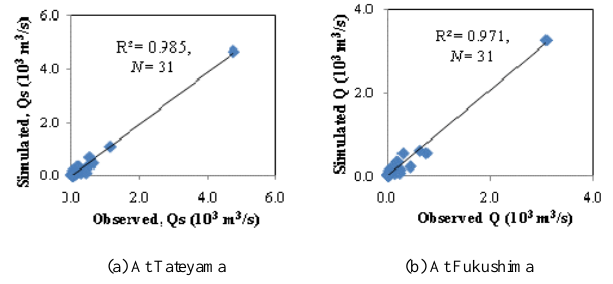
Fig. 8. Correlation of observed and simulated daily avg. water discharge ( N = number of observations).